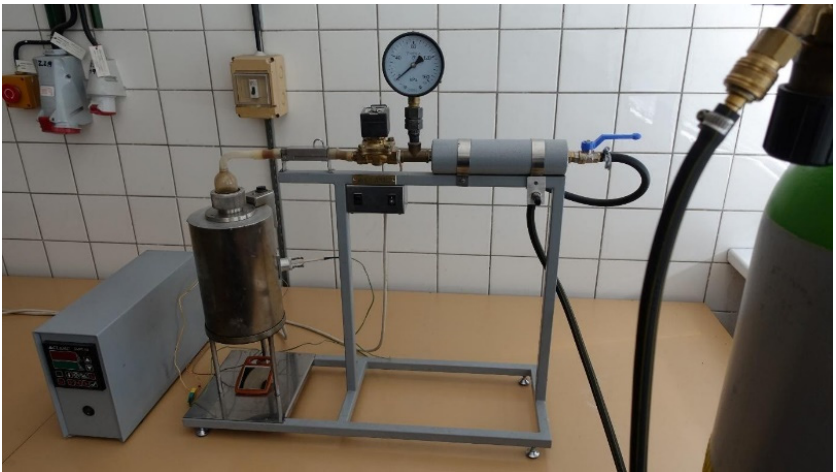
Figure 5. G-G furnace for determination of MIT of dispersed dust.